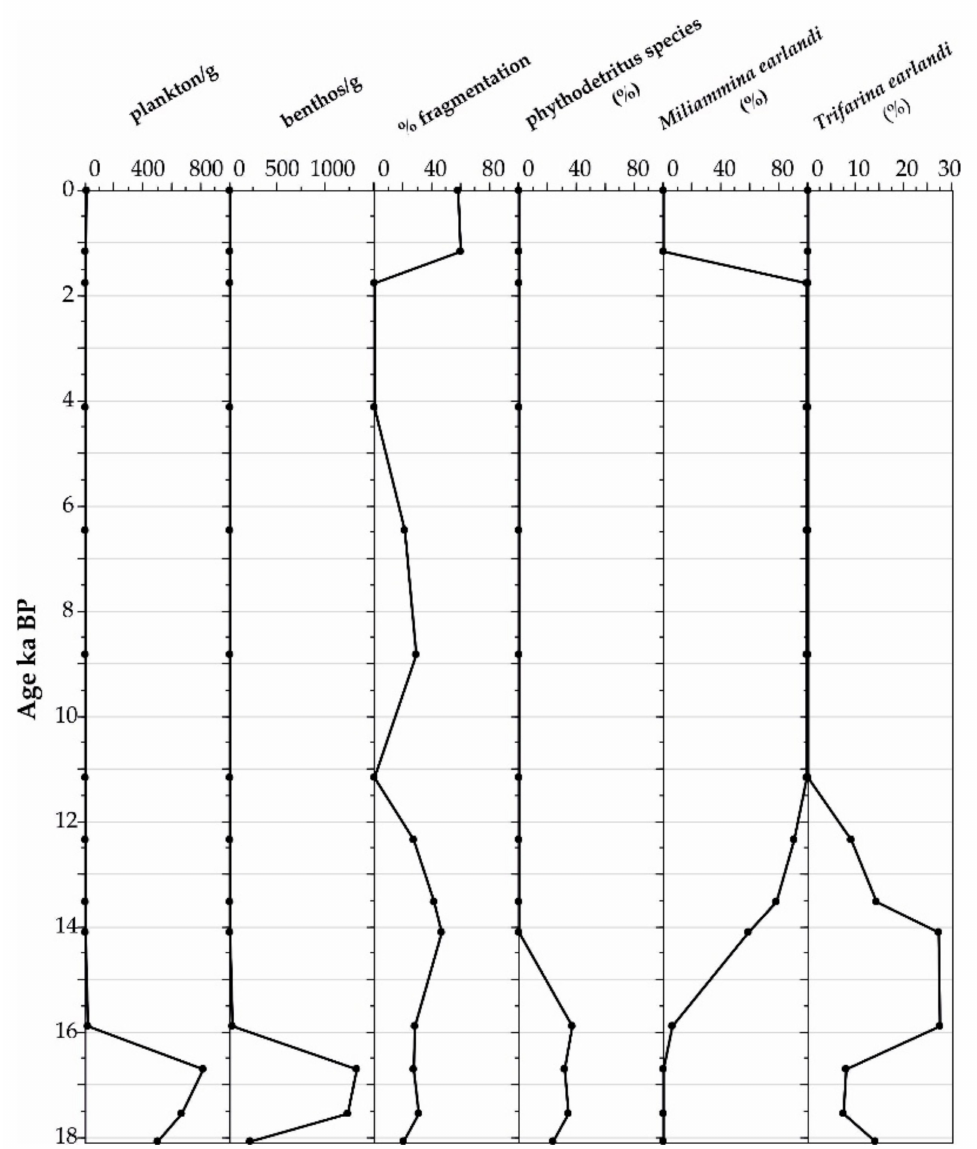
Figure 11. From left to right: down-core distribution in BC03 of planktic N. pachyderma and benthonic foraminifera (as the number of specimens per gram of dry sediment), fragmentation (%), and relative abundance (%) of benthic foraminifera. The phytodetritus species includes the % of A. weddellensis and E. exigua